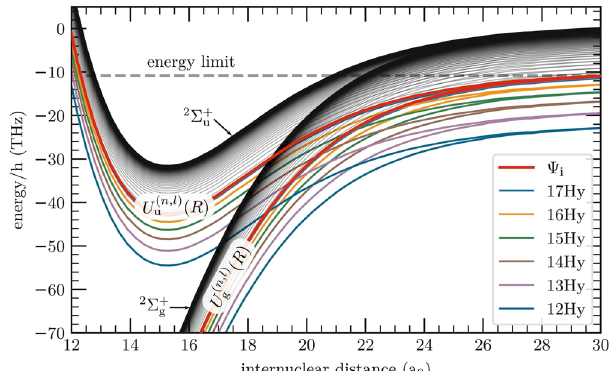
Fig. 9 Potential energy landscape of a Rydberg quasi-molecular complex. The molecular PECs split into two branches, which belong to the 2 Σ þ 2 Σ þ components of the quasi-molecular ion. The highest-lying PEC of each u branch belongs to U g ( R ) ( U u ( R )) of the molecular ion. All other PECs U ð n ; l Þ ð R Þ are shifted by the binding energy of the Rydberg electron. g ; u